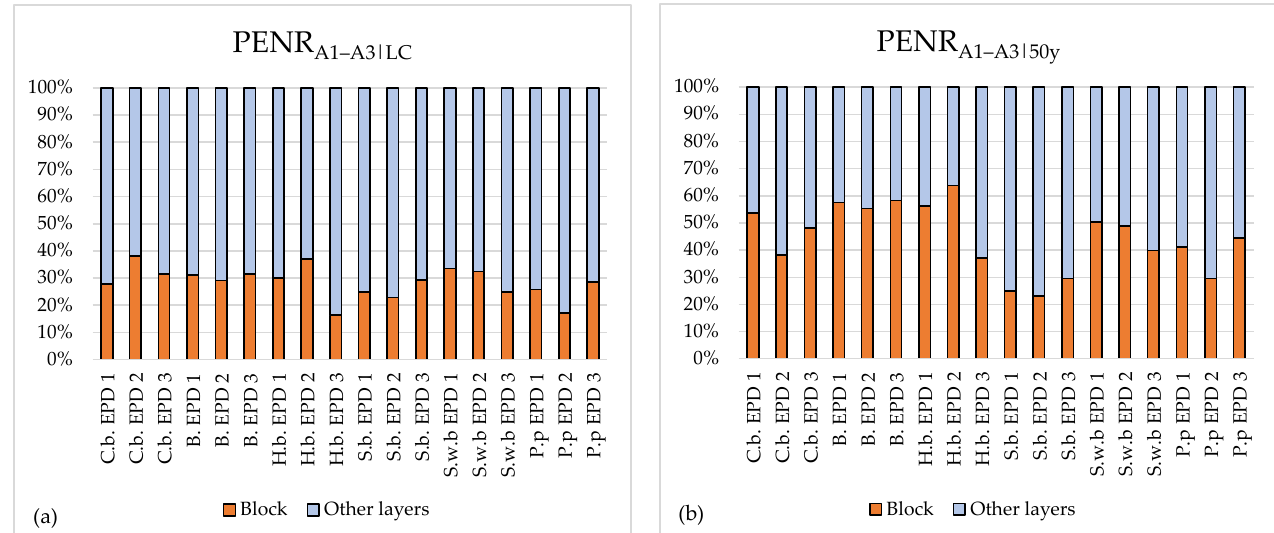
Figure 9. ( a ) PENR A1–A3|LC and ( b ) PENR A1–A3|50y : contribution of construction blocks and other layers to the total. (C.b. = Concrete block; B. = Bricks; H.b. = Hollow bricks; S.b. = Sandstone bricks; S.w.b = Shuttering wood chips blocks; P.p. = Prefabricate concrete panels).